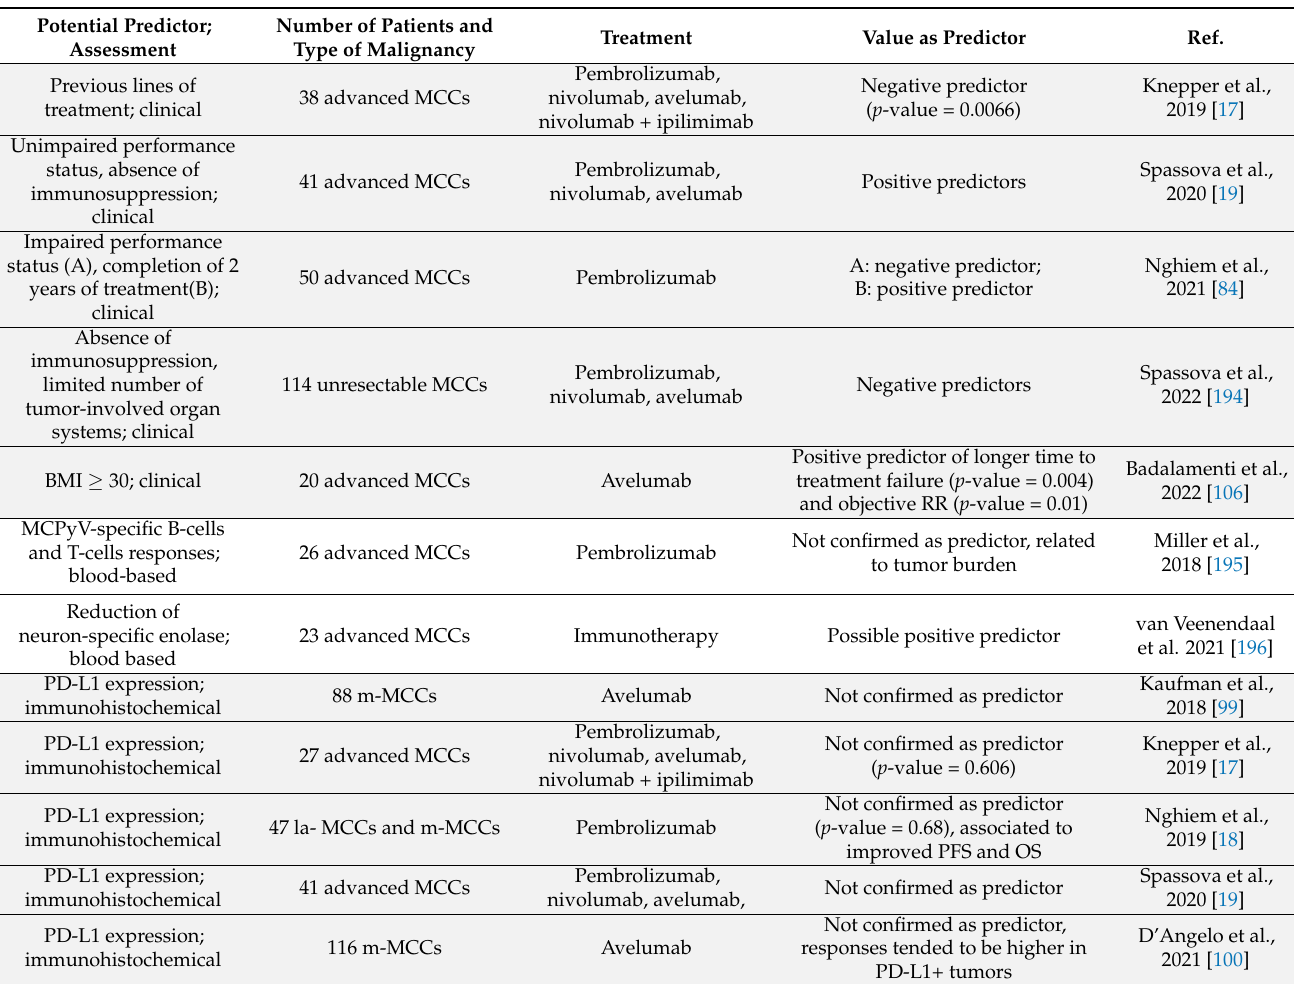
Table 8. Possible predictors to immune checkpoint inhibitor response in locally advanced and metastatic Merkel cell